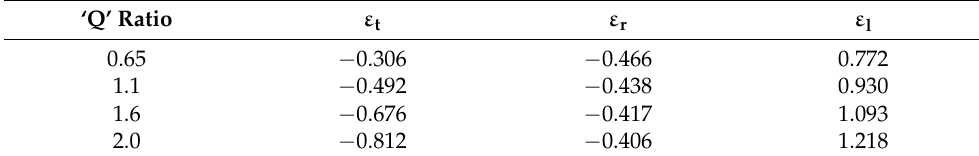
Table 3. The strain of Ti-3Al-2.5V tube rolling pass.